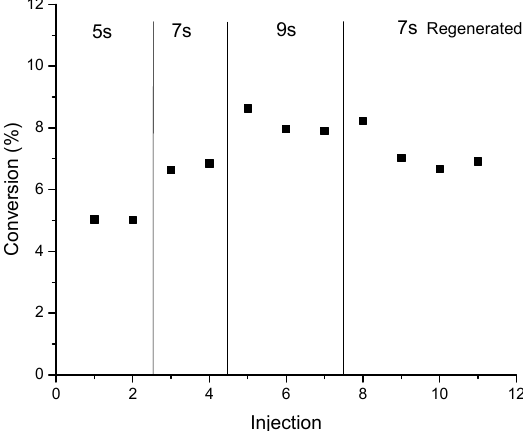
Figure A3. Detailed C 3 = / C 3 ratio ( ⬛ ), H 2 ( 0 ), C 2 = ( ⯅ ), and C 4 ( ▽ ) selectivity for injections on the riser simulator at 500 °C with different contact time, compared to injections after regeneration at the same conditions. (changes of selectivity after first injection).